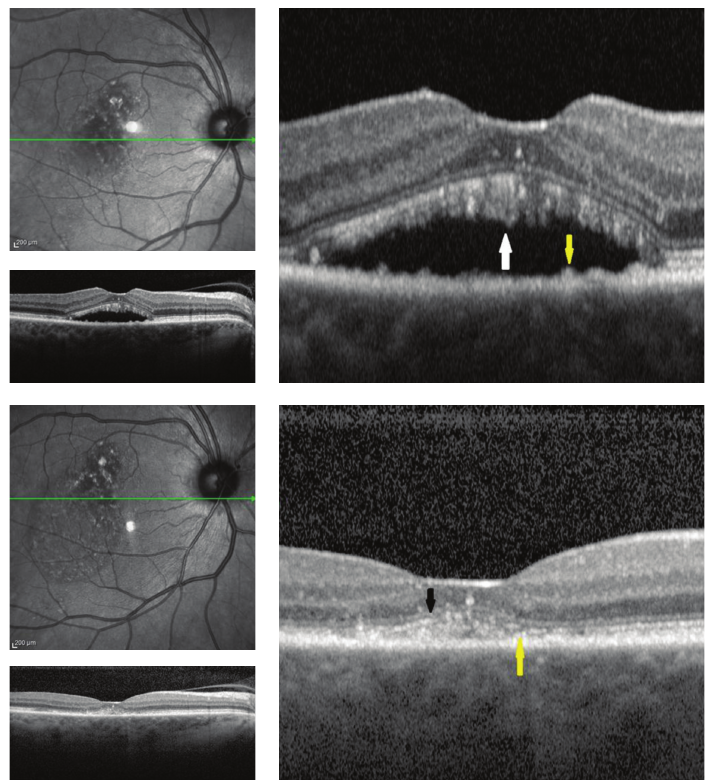
Figure 2: (Top) Chronic CSC before laser treatment. (Top right) SD-OCT shows elongation of photoreceptors layer with most protruding outer segment of photoreceptors (white arrow) and hyperreflective subretinal deposits demonstrated a noticeable bulge in the RPE (yellow arrow). (Bottom) 12 months after laser treatment. (Bottom right) SD-OCT shows disruption of the foveal photoreceptor layer and ELM (black arrow), and hyper-reflective subretinal deposits demonstrated a noticeable bulge in the RPE (yellow